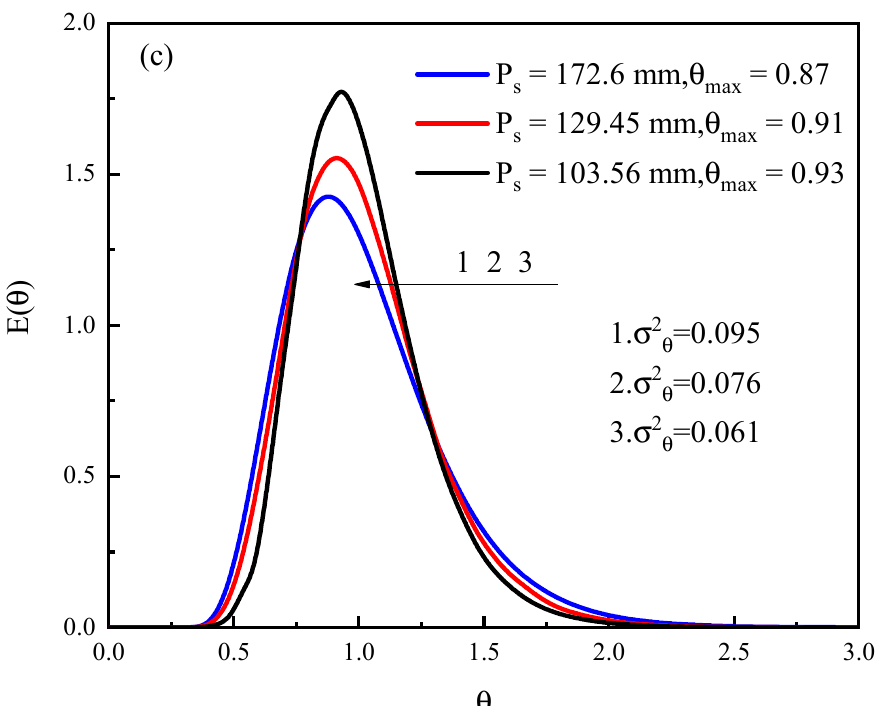
Figure 8. Plot of the effect of pole plate spacing on the RTD curve (( a ): The residence time distribution curves of the reactor when V is 2.6 m/s, P l is 490 mm, and P s is 172.6, 129.45 and 103.56 mm, respectively; ( b ): The residence time distribution curves of the reactor when V is 2.6 m/s, P l is 560 mm, and P s is 172.6, 129.45 and 103.56 mm, respectively; ( c ): The residence time distribution curves of the reactor when V is 2.6 m/s, P l is 630 mm, and P s is 172.6, 129.45 and 103.56 mm, respectively).